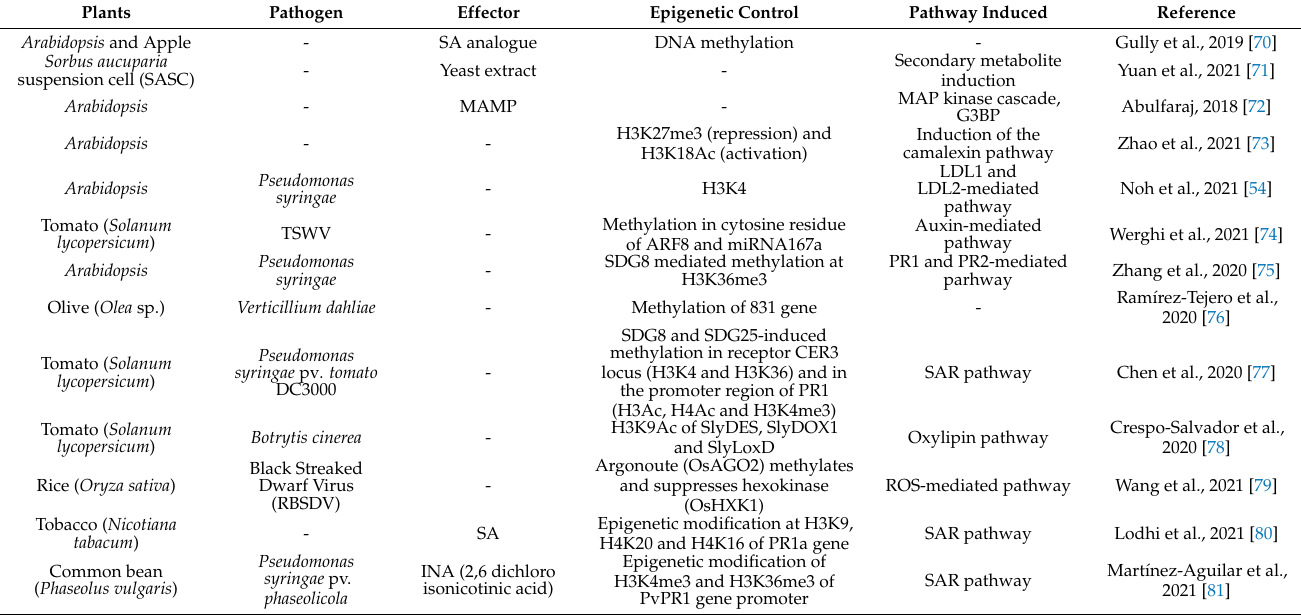
Table 1. List of biotic interactions contributing to stress memory in